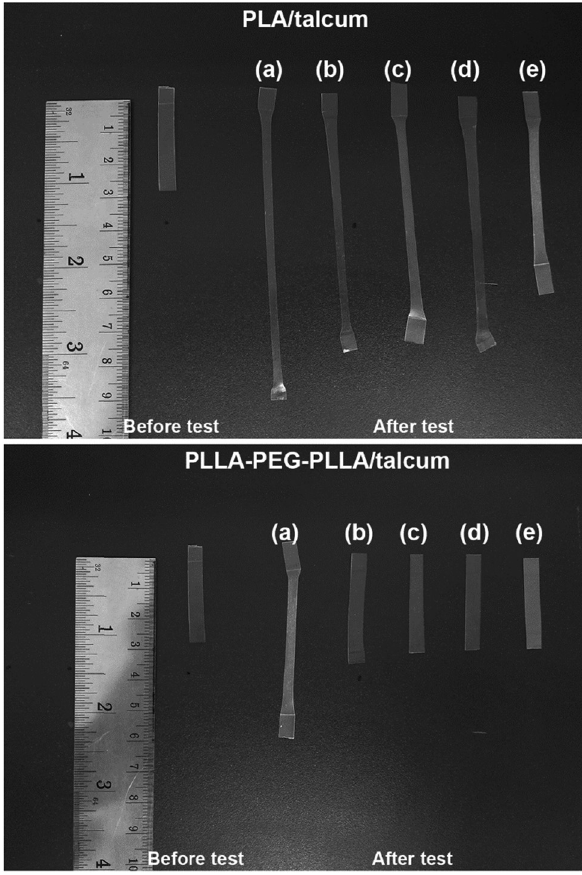
Figure 7: Dimensionalstabilitytoheatat80°Cunder200gloadfor30sof ( above ) PLLA/talcum and ( below ) PLLA - PEG - PLLA/talcum fi lms ( a ) without talcum and with talcum contents of ( b ) 1, ( c ) 2, ( d ) 4, and ( e ) 8wt%.